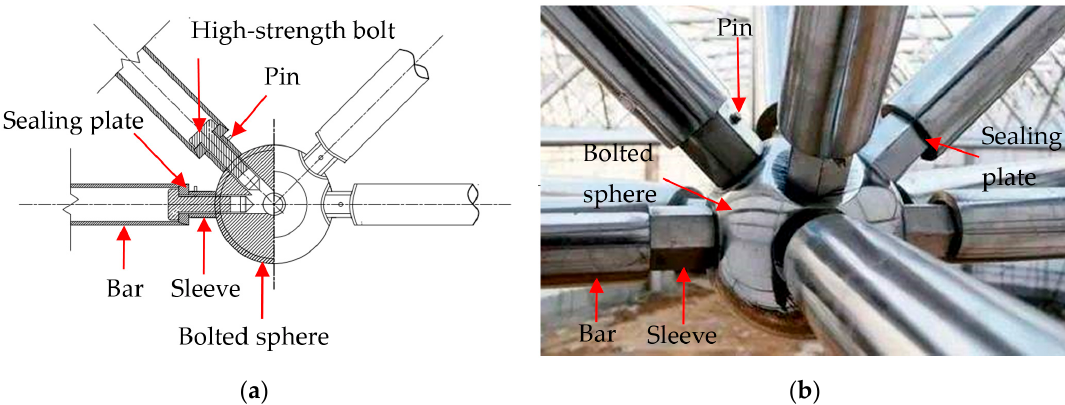
Figure 1. ( a ) Diagram of bolted spherical joint parts; ( b ) Photo of bolted spherical joint of the roof at Qingdao airport terminal-A.